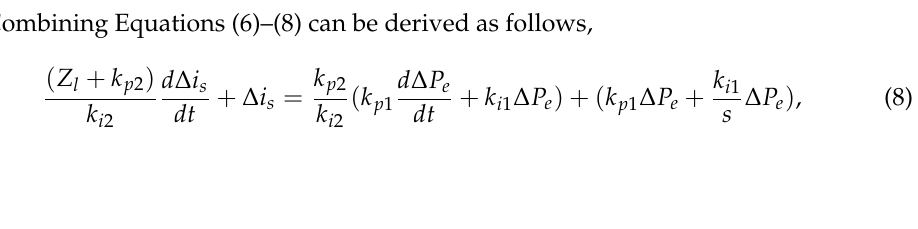
Figure 3. The vector diagram of PMSG controlled by